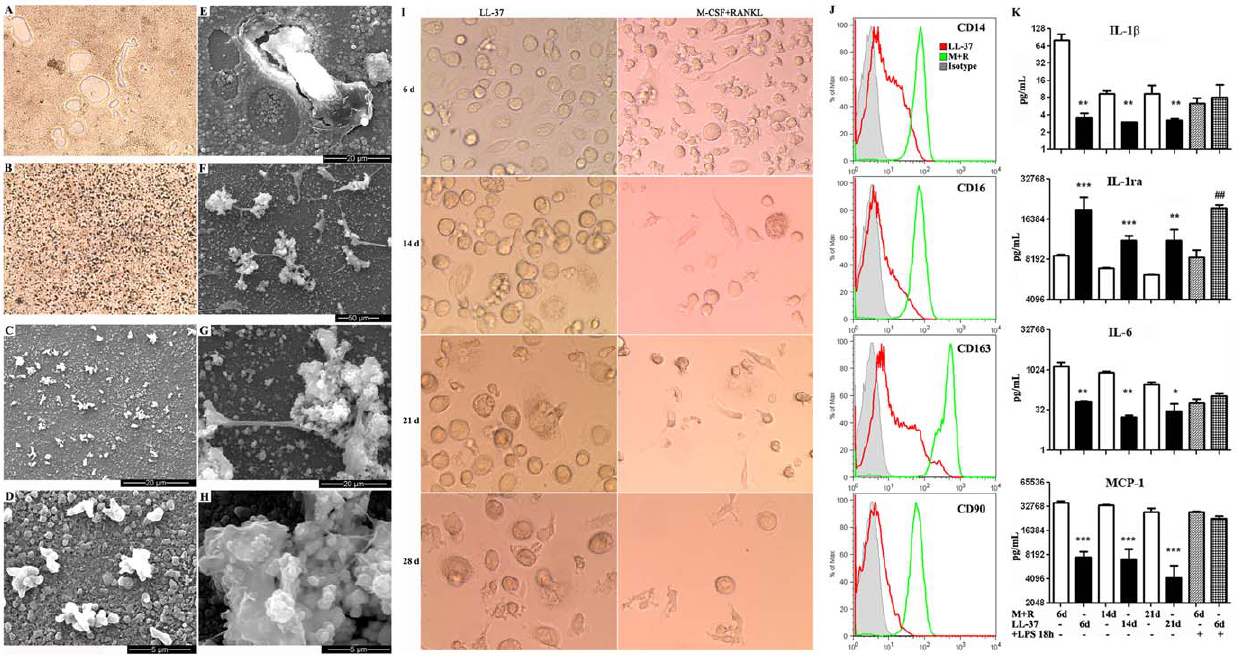
Figure 2. LL-37-differentiated monocytes are a novel type of bone forming cells (monoosteophils). Monocytes were incubated in the presence of M-CSF/RANKL (both at 25 ng/mL, A , E ) or 5 m M LL-37 ( B,C,D,F,G,H ) on BioCoat TM Osteologic TM Discs in 5% CO 2 atmosphere. After incubation for 3 weeks, cells were removed with bleach and observed by phase contrast microscopy (magnification 6 200, A , B ) or scanning electron microscopy (SEM) ( C , D ). Pit formation was shown on the disc incubated with M-CSF/RANKL-differentiated monocytes ( A ). Refractile specks were shown on the disc incubated with LL-37-differentiated monocytes ( B ). SEM showed the refractile specks are built-up granules with a shallow absorbed zone ( C , D ). After incubation for 7 weeks, pit formation and osteoclast are shown on the disc incubated with M-CSF/RANKL-differentiated monocytes by using SEM ( E ), and built-up structures and cells are shown on the disc of LL-37-differentiated monocytes ( F–H ). Monocytes at concentration of 1 6 10 6 /mL were incubated with 5 m M LL-37 or M-CSF/RANKL (both at 25 ng/mL). I . Morphology was evaluated by phase contrast microscopy (magnification 200 6 ). J . After incubation for 6 days, LL-37- and M-CSF/RANKL-differentiated monocytes were harvested, stained with antibodies, and analyzed by flow cytometry. K . Cytokine levels in the supernatant of LL-37- and M-CSF/RANKL-differentiated monocytes were analyzed. In the LPS treated experiment, 6-day LL-37- and M-CSF/RANKL-differentiated monocytes were collected, resuspended at the concentration of 1 6 10 6 /mL, and incubated with 100 ng/mL LPS for 18 h and cytokine levels were detected in the supernatant (mean 6 SE, n=3). Data represent three independent experiments performed. M + R: M-CSF + RANKL. ** p , 0.01, *** p , 0.001 in comparison with M-CSF/RANKL-differentiated monocytes; ## p , 0.01 in comparison with M-CSF/RANKL-differentiated monocytes treated with LPS for 18